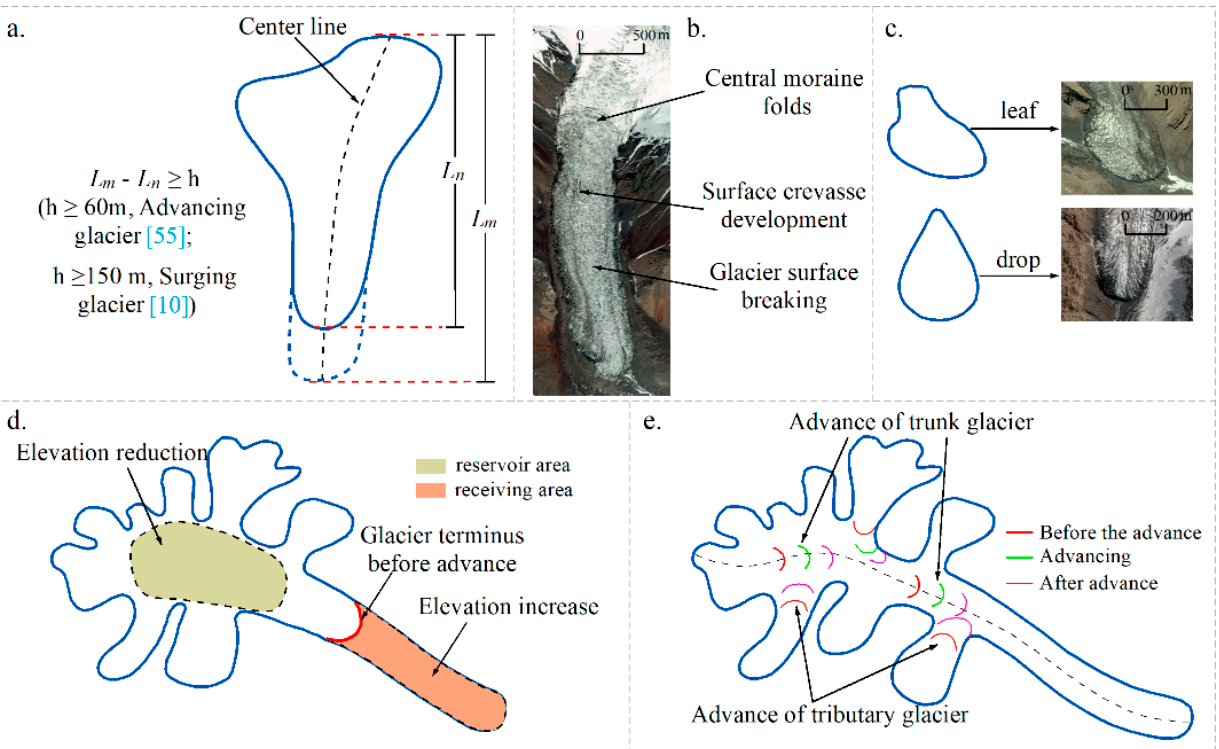
Figure 5. Diagrams of advancing and surging glaciers: ( a ) drawing of terminal changes in advancing and surging glaciers; ( b ) aerial photo of surface characteristics of surging glaciers; ( c ) aerial photo of terminal shapes (leaf and drop shapes) of surging glaciers; ( d ) drawing illustrating changes in surface elevation of surging glaciers; ( e ) drawing illustrating glacier forms with surface advance. Note: h—length of glacier advance; L m —length of glacier after advance; L n —length of glacier before advance. The images in figure ( b , c ) are Google Earth historical images. 3. Results Based on Landsat TM/ETM+/OLI images and glacier inventory data, 48 glaciers were found to have advanced to various extent by comparing changes of each glacier from 1990 to 2019 in the Tien Shan Range (Figure 6). Among them, 34 glacial termini advanced sig- nificantly, and 14 glacier surfaces advanced. According to the method of identification of advancing and surging glaciers, 10 of the 34 terminal advances of glaciers were identified as surging glaciers, and the others were advancing glaciers. Table 1 lists the basic param- eters of these glaciers. The 48 advancing glaciers identified here are mainly located in the western part of Halik Mountain and Kungey Mountain in the Central Tien Shan, and in